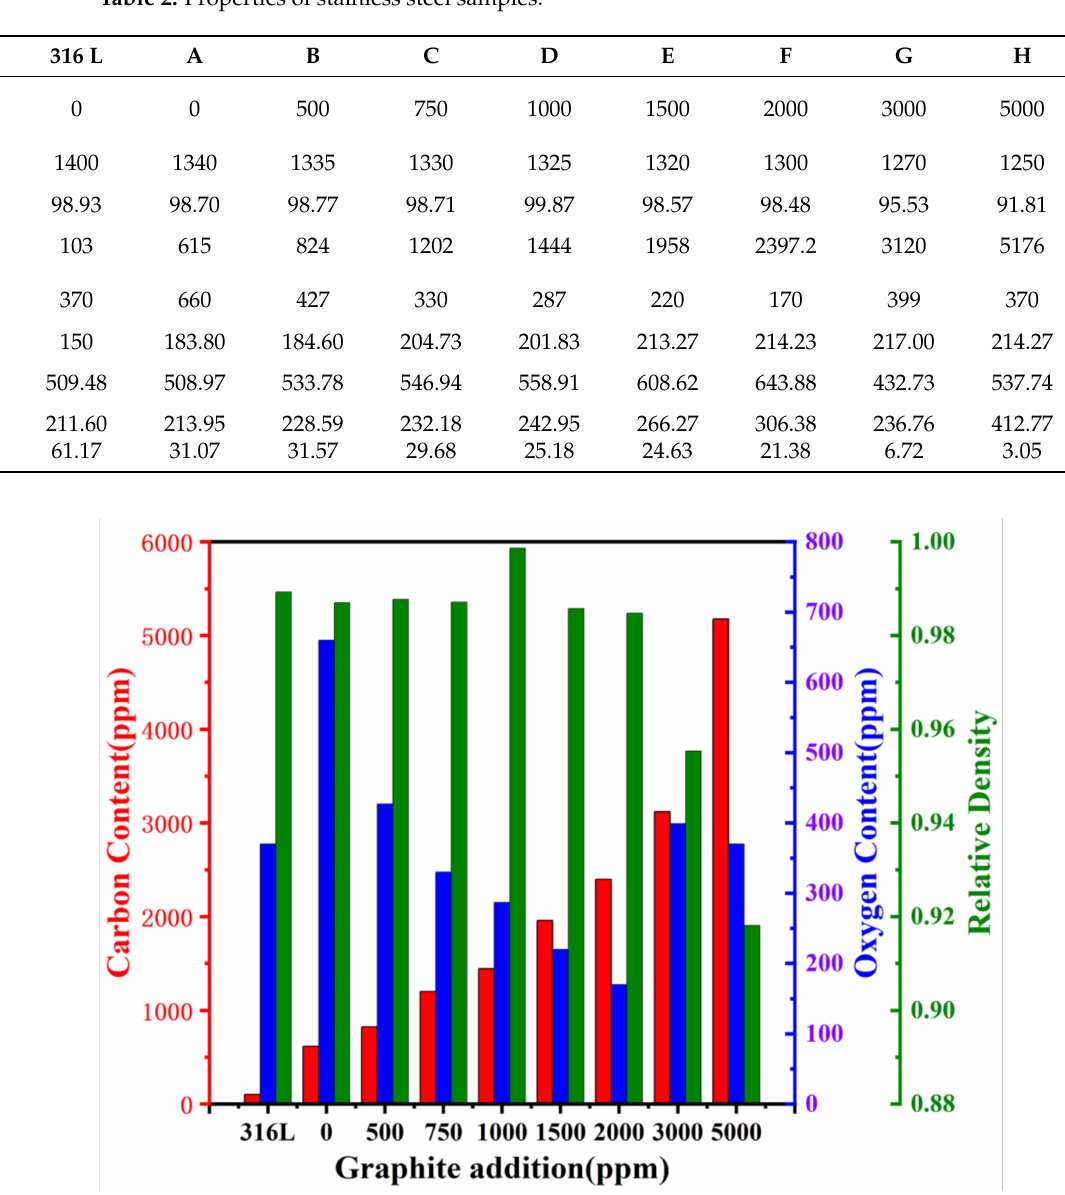
Figure 2. Sintering properties of as-sintered stainless steel